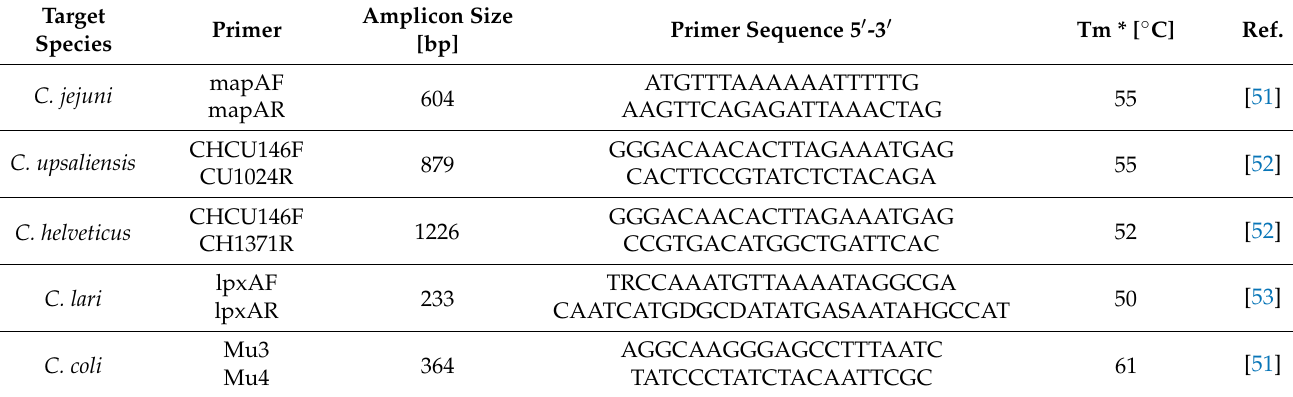
Table 2. Primers used in this study for Campylobacter species